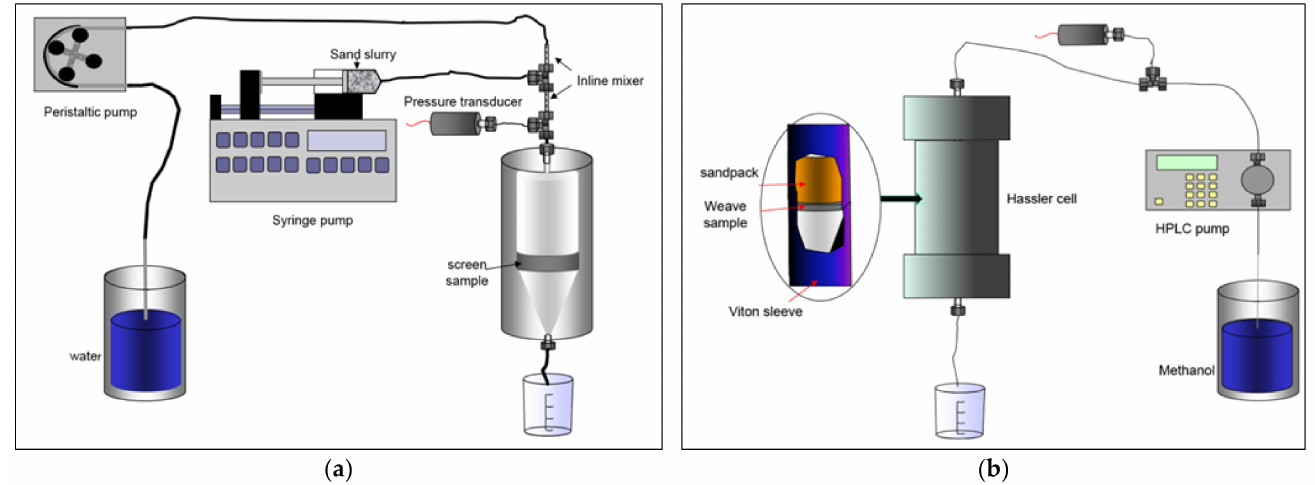
Figure 1. Sand retention test (SRT) experimental setup [4]: ( a ) Slurry test; ( b ) Sand pack